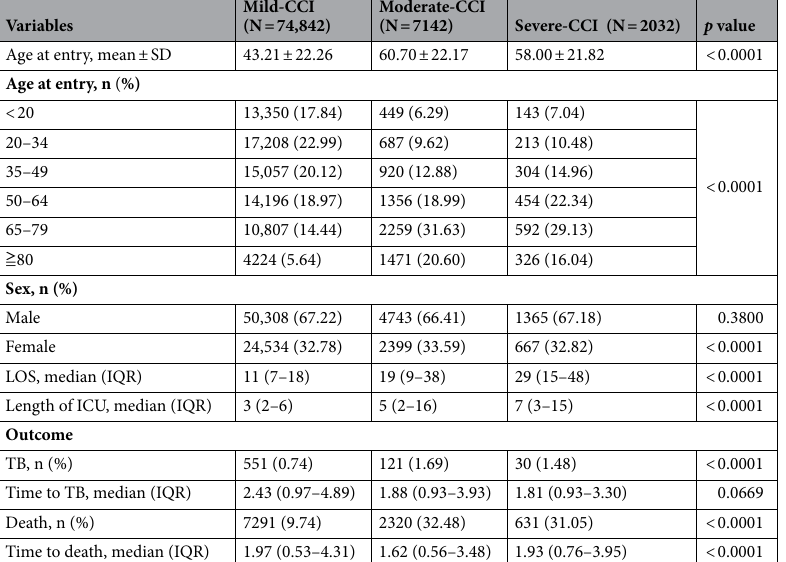
Table 3. The baseline information among TBI patients with different Charlson’s Comorbidity Index groups. CCI Charlson’s comorbidity index, ICU intensive care unit, LOS length of stay, TB tuberculosis, TBI traumatic brain injury, IQR interquartile range, SD standard deviation.